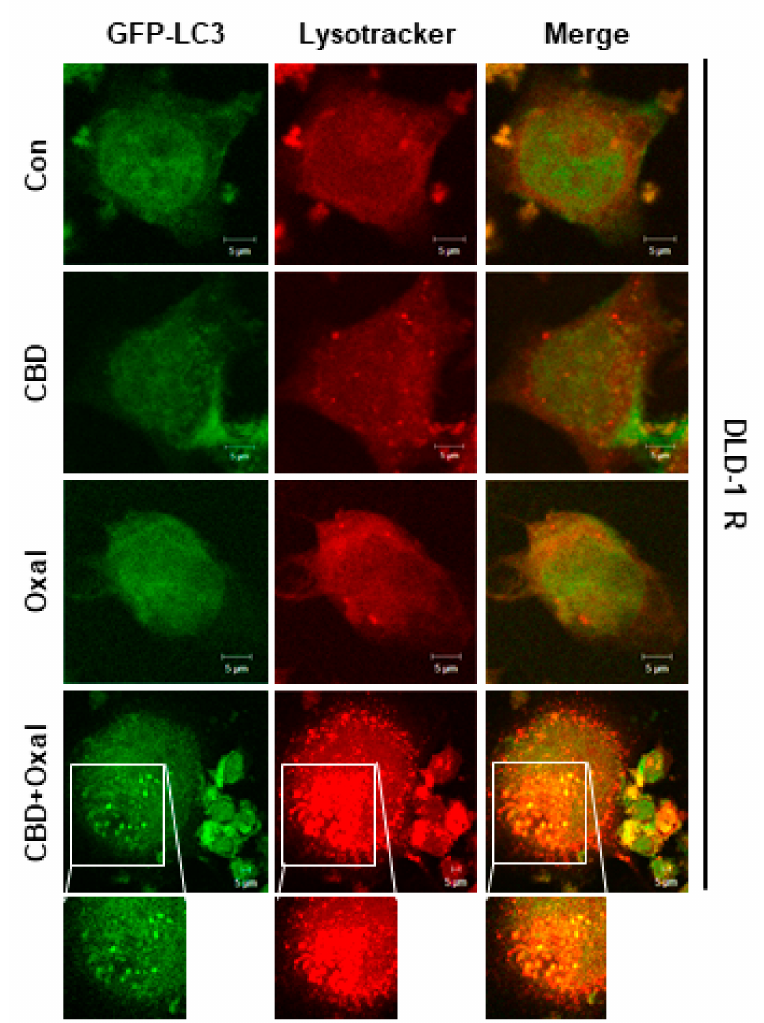
Figure A1. Oxaliplatin and CBD induces autophagy. The formation of GFP-LC3 puncta after treatment with oxaliplatin and CBD was analyzed by confocal microscopy in DLD-1 R cells (Scale Bar, 5 µ